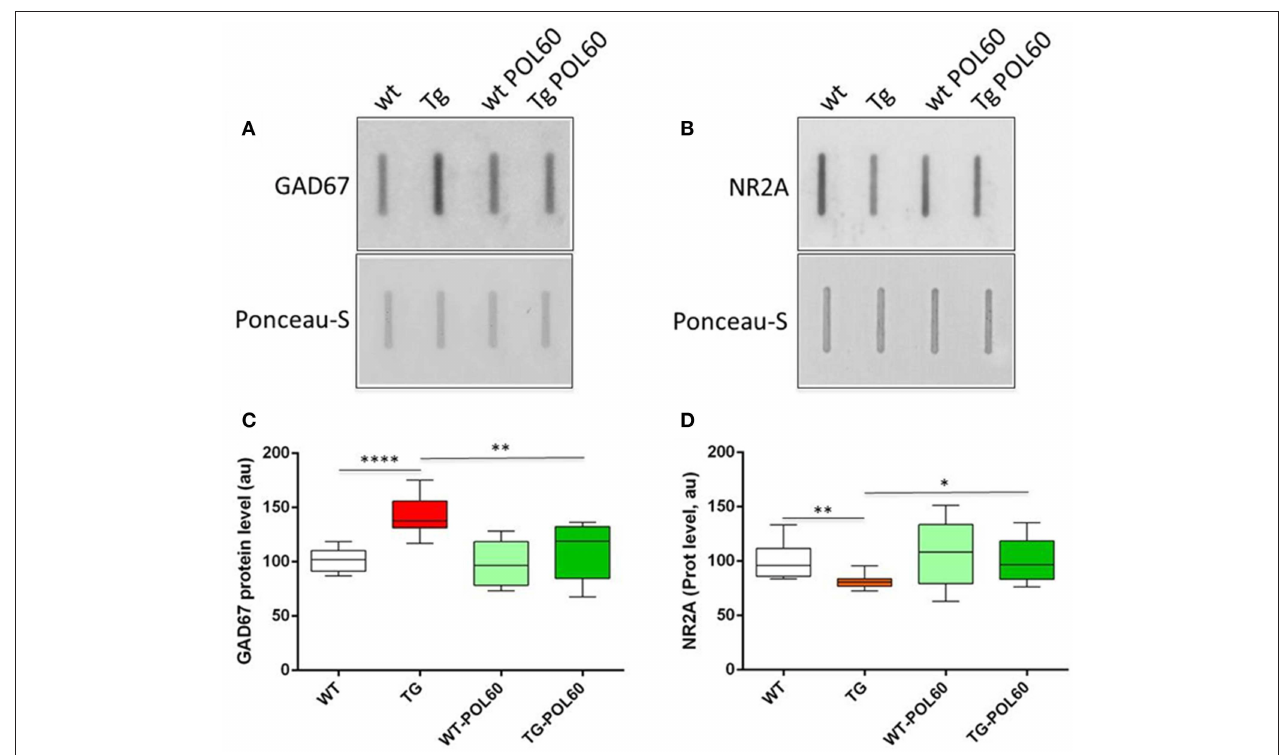
FIGURE 1 | Effect of long-term POL60 treatment on GAD67 and NR2A levels in hippocampus: Immunoblotting of proteins from wt and mBACtgDyrk1a hippocampus treated with placebo or POL60 for (A) GAD67 and (B) NR2A. Ponceau-S coloration was used to assess total protein levels. Below: boxplots of expression relative to WT placebo (WT) for (C) GAD67 and (D) NR2A. * p < 0.05 , ** p < 0.01 , **** p < 0.0001 .